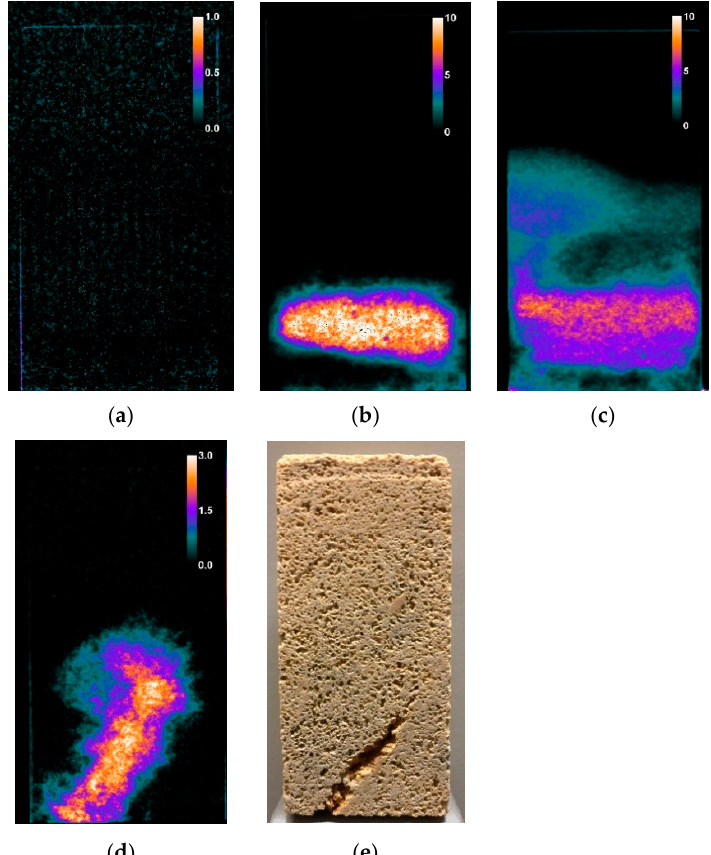
Figure 7. St. Margarethen Limestone radiographs recorded after 30 min of water absorption by capillarity and displaying the water amount in wt. % for specimens treated with NC-25C by ( a ) capillary absorption, ( b ) brushing and ( c ) poultice. A radiograph ( d ) displays the water absorption by capillarity in the presence of a vugular porosity and ( e ) the so-called vugs, which are large cavities in a natural stone, usually exhibiting mineral precipitants on the pore walls.